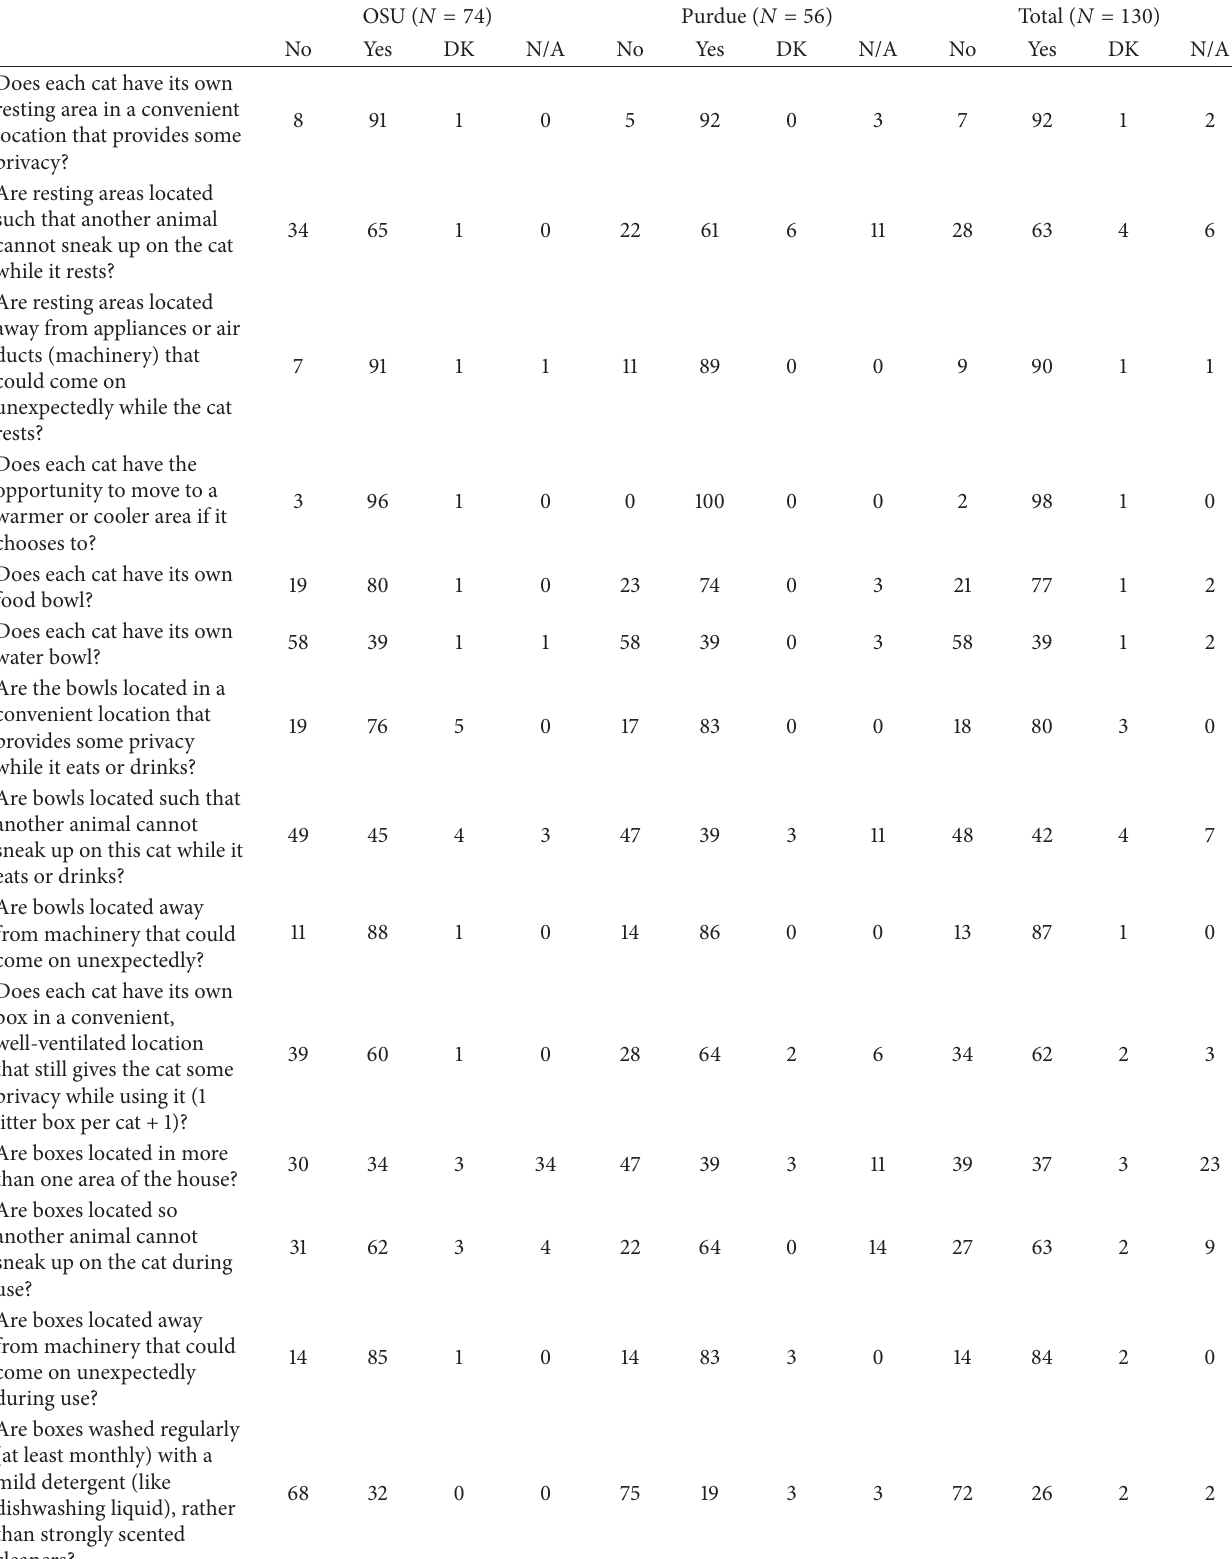
Table 6: Owner-reported resources provided to cats